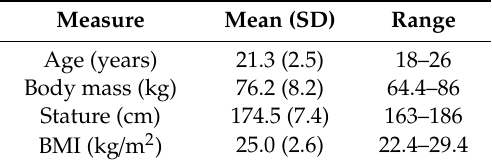
Table 1. Summary of participant characteristics (SD = standard